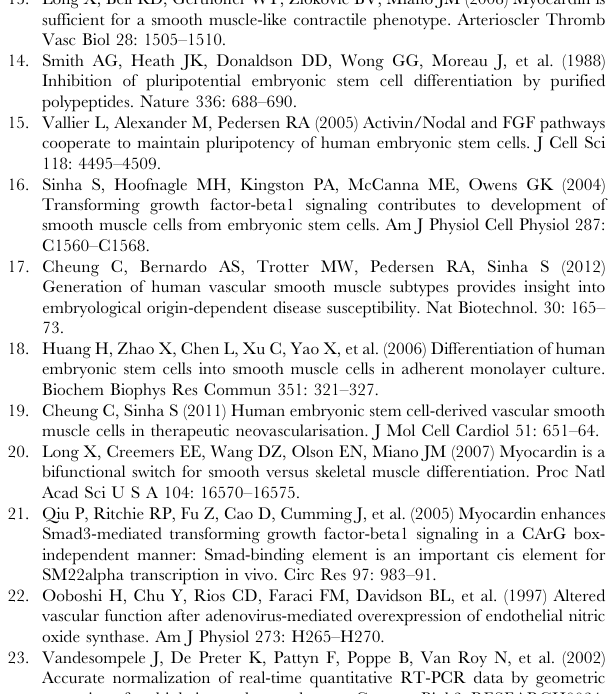
Figure S4 Myocardin overexpression increases human ESC-derived SMC contractility. Human ESCs were induced to undergo differentiation on a 2-dimensional surface using defined growth factors. Two days after Ad-LacZ or Ad-Myo transduction, individual SMCs were visualised at 0 min and